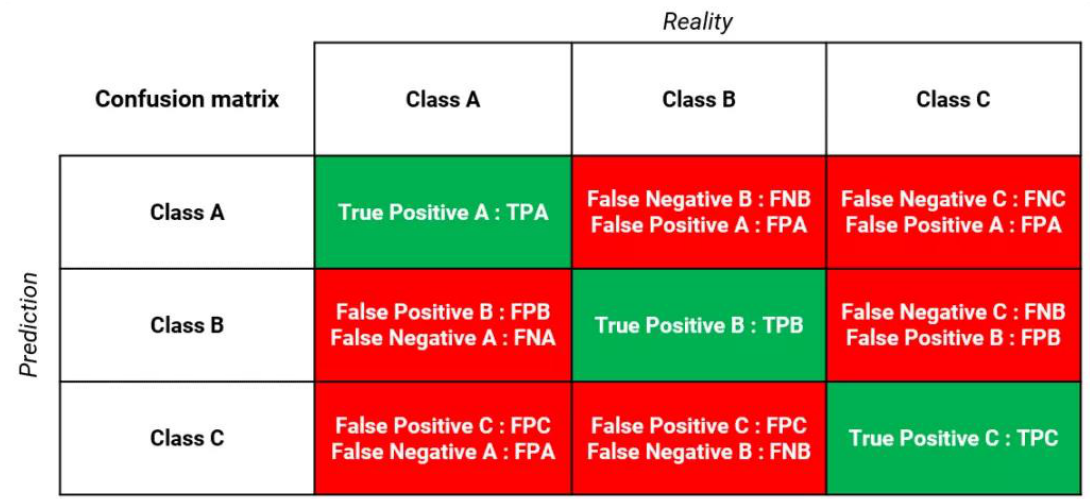
Figure 5. The Confusion Matrix in case of 3 classes [69].